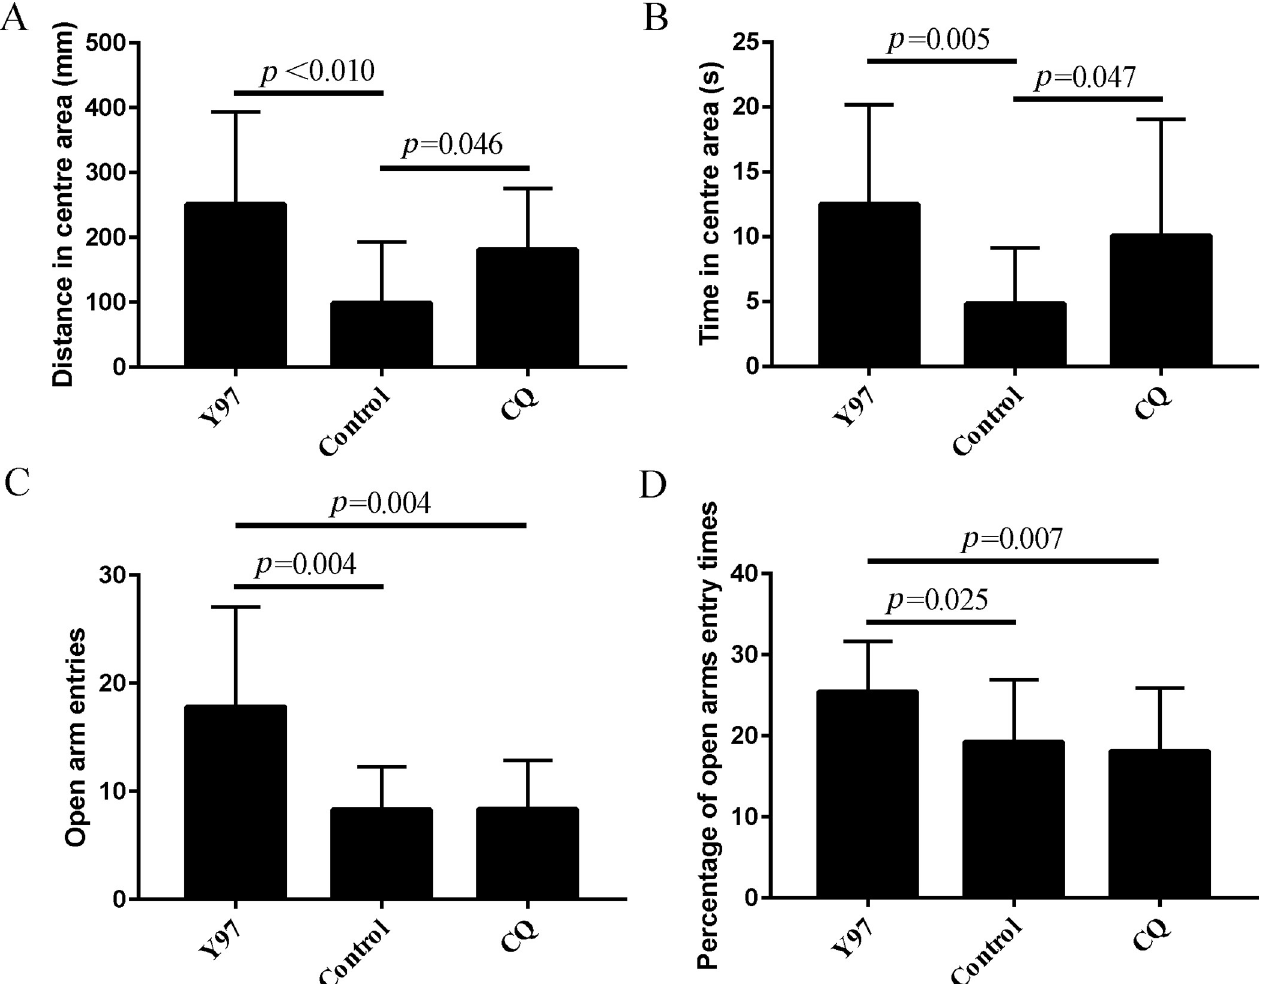
Fig 5. Behavioral experimental results of three groups of mice. 1. CQ represented mice fed with Companilactobacillus futsaii subsp. chonqingii CQ16Z1, Y97 represented mice fed with Companilactobacillus futsaii subsp. futsaii YM0097. 2. A showed the distance in centre area, and B showed the time in centre area, C showed the number of entries to the open arms and D showed the percentage of open arms entry times. 3. Data were presented as mean ± SEM. One-way ANOVA followed by LSD test and Tamhane’s T2 test. The significance level was α = 0.05. (n = 14–16 mice per